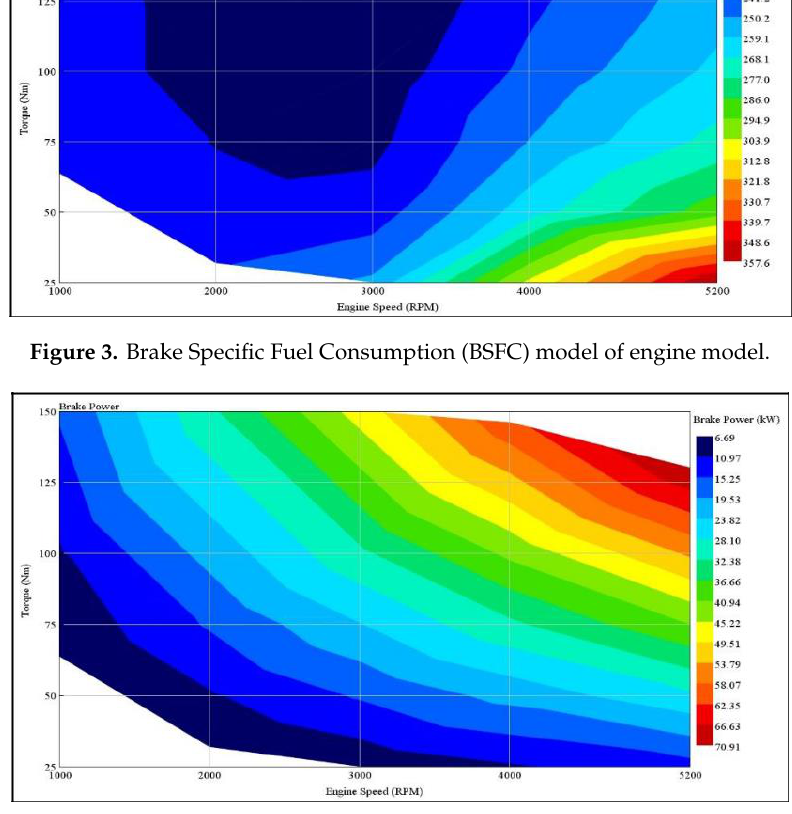
Figure 4. Brake power of engine model.